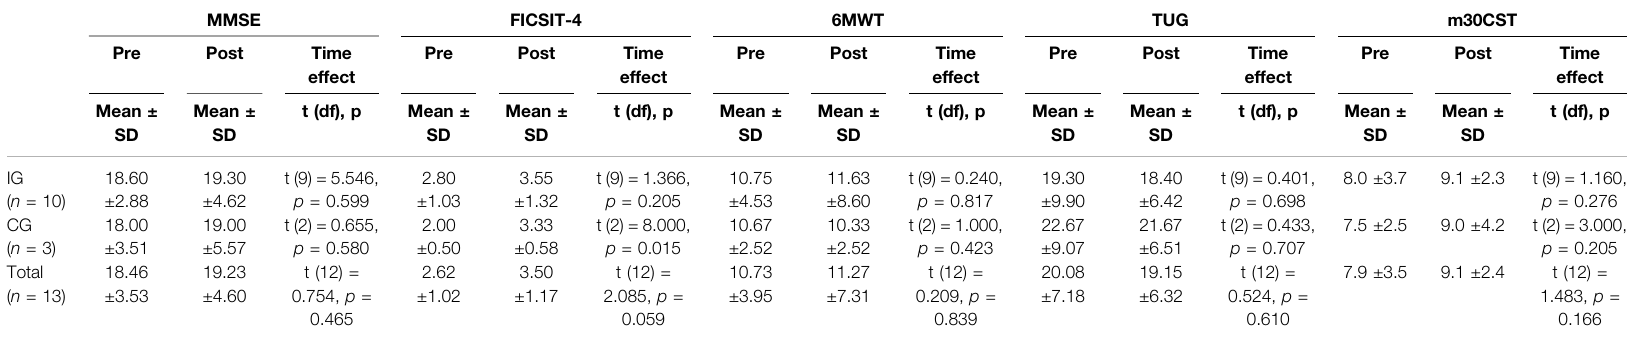
TABLE 6 | Results on the